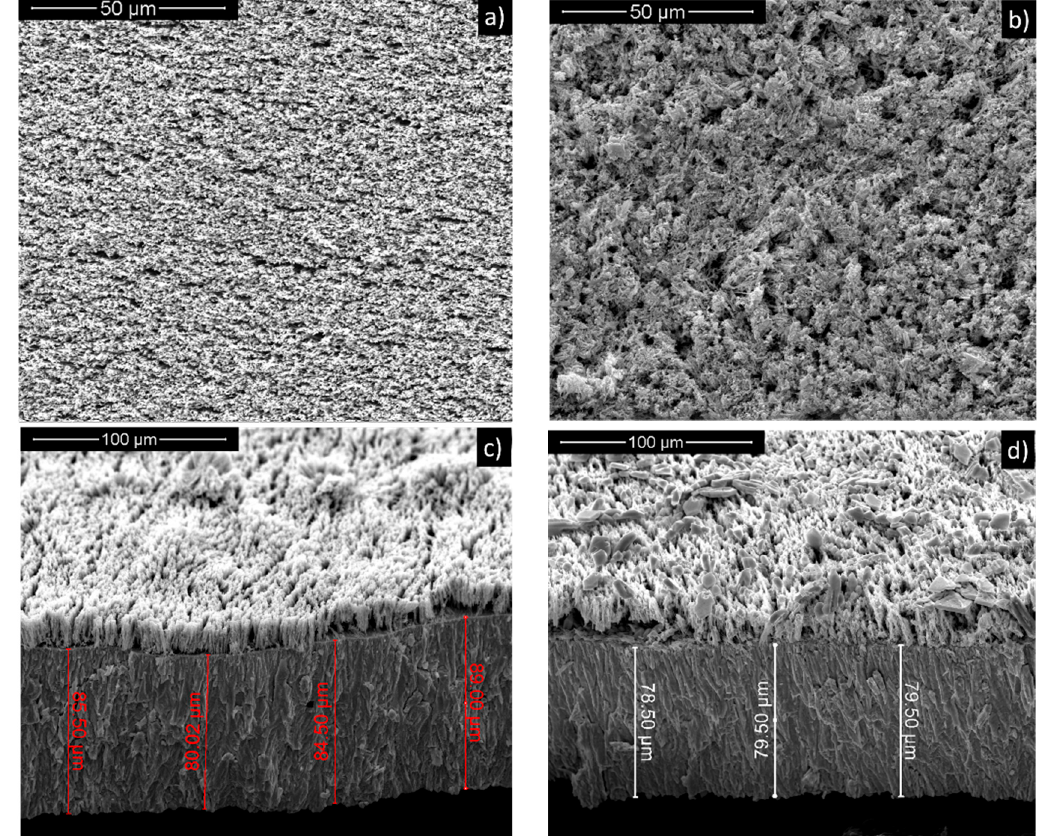
Figure 3. SEM images of PbO 2 NW electrode: ( a ) top view before the conditioning phase, ( b ) top view after the conditioning phase, ( c ) cross-sectional view before the conditioning phase and ( d ) cross-sectional view after the conditioning phase.